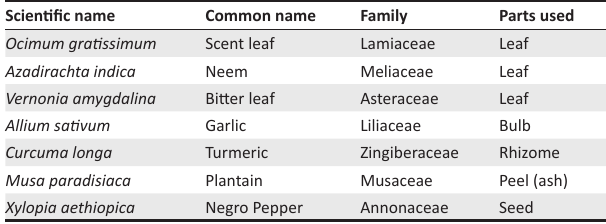
TABLE 1: Plants evaluated for insecticidal